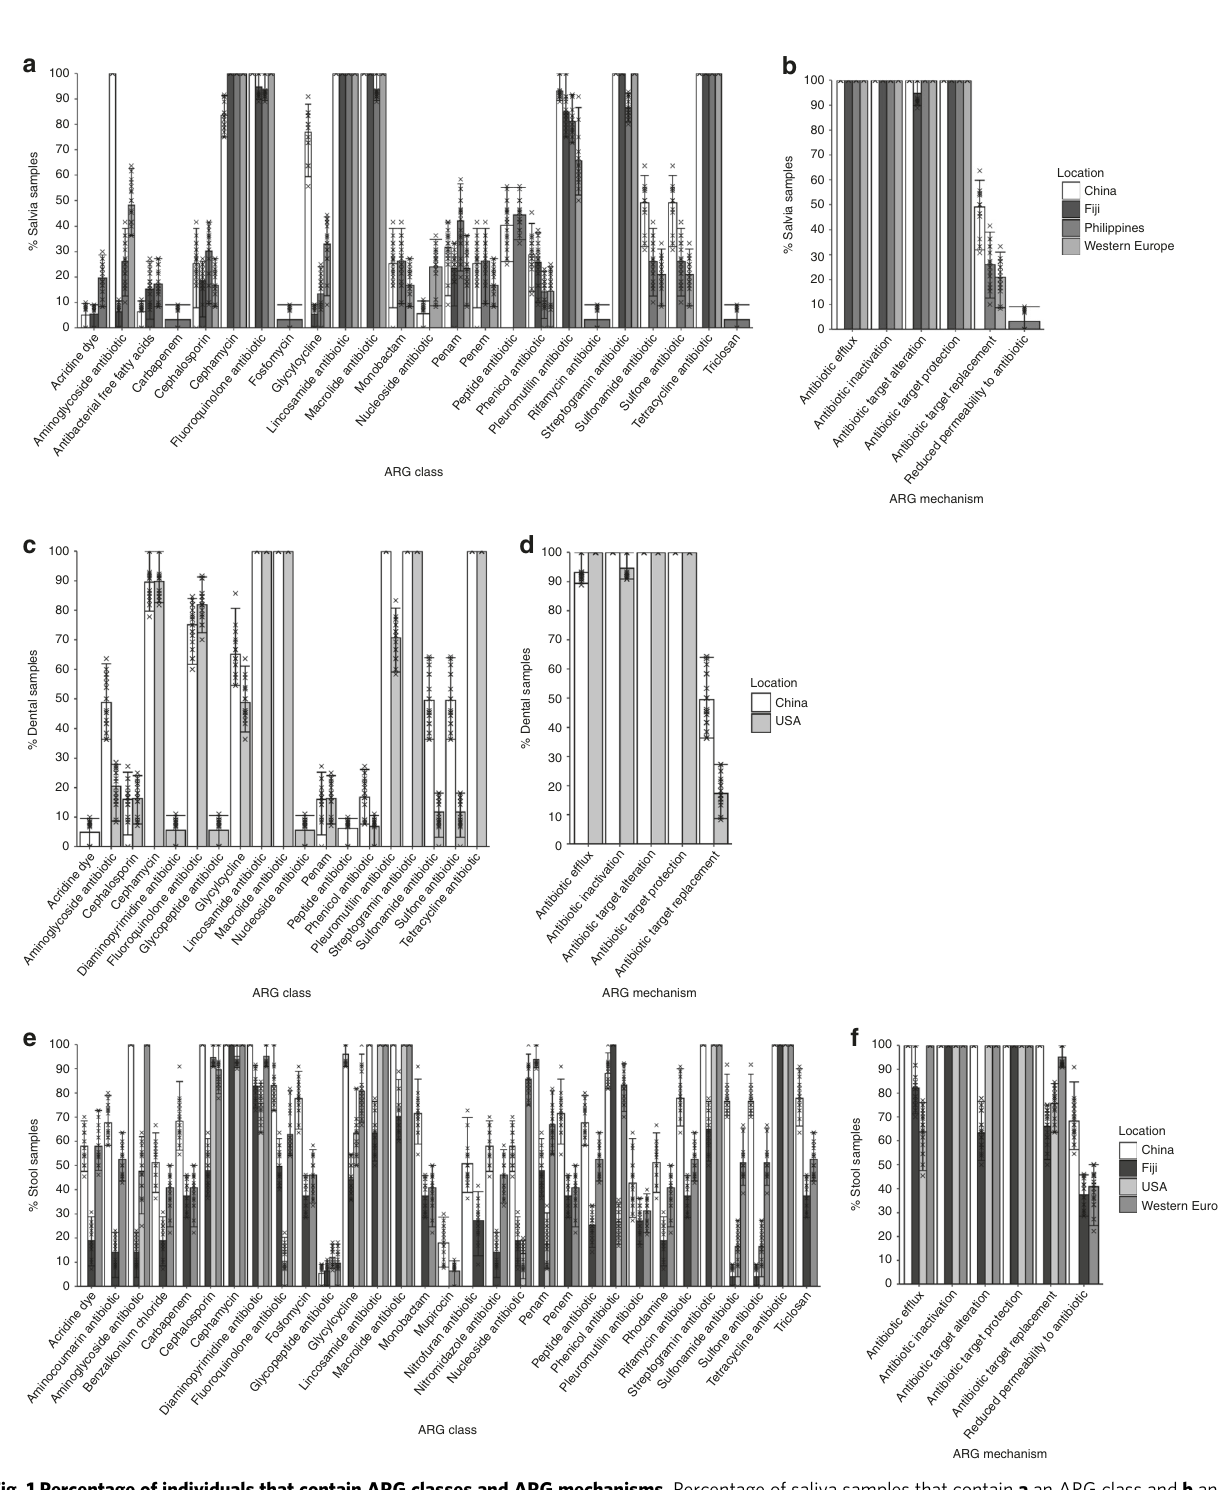
Fig. 1 Percentage of individuals that contain ARG classes and ARG mechanisms. Percentage of saliva samples that contain a an ARG class and b an ARG mechanism, of individuals from China ( n = 18), Fiji ( n = 18), the Philippines ( n = 18) and Western Europe ( n = 18). Percentage of dental plaque samples that contain c an ARG class and d an ARG mechanism, of individuals from China ( n = 18) and the USA ( n = 18). Percentage of stool samples that contain, e an ARG class and f an ARG mechanism, of individuals from China ( n = 18), Fiji ( n = 18), the USA ( n = 18) and Western Europe ( n = 18). The height of bars are the means and the error bars are 95% con fi dence intervals (CIs) of percentages extracted from bootstrapping samples 20 times shown by points. Source data are provided in the Source Data fi